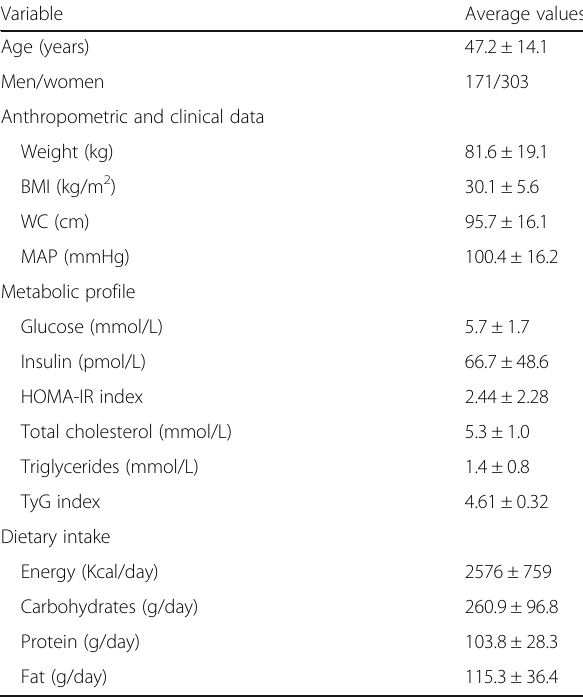
characteristics as well as dietary intake of the whole study population ( n =